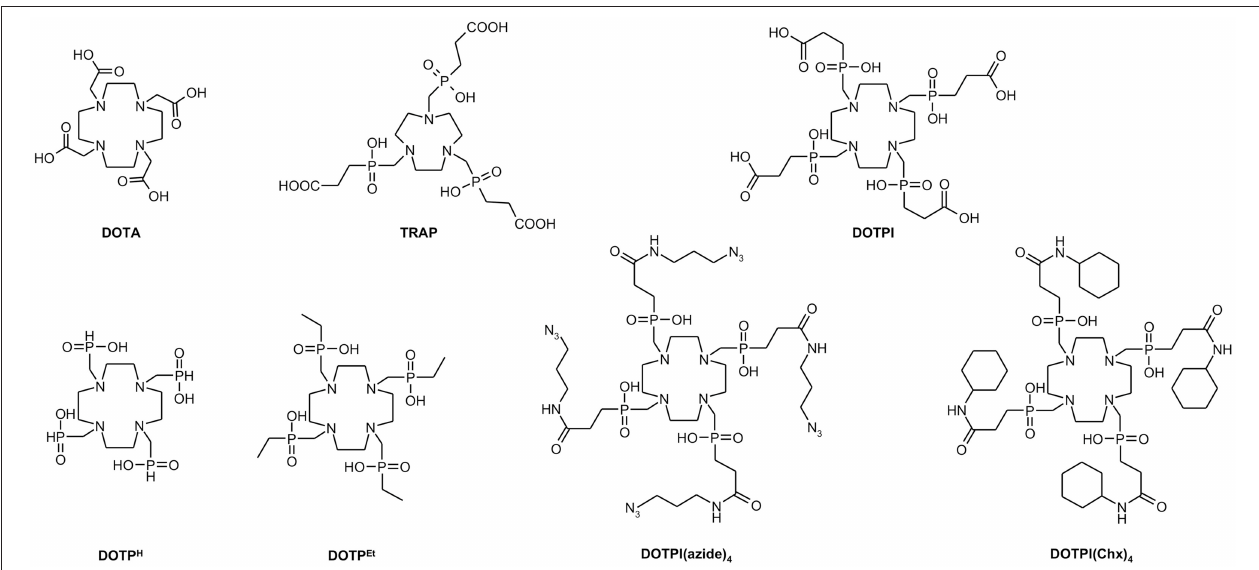
FIGURE 1 | Structures of chelate ligands discussed in the